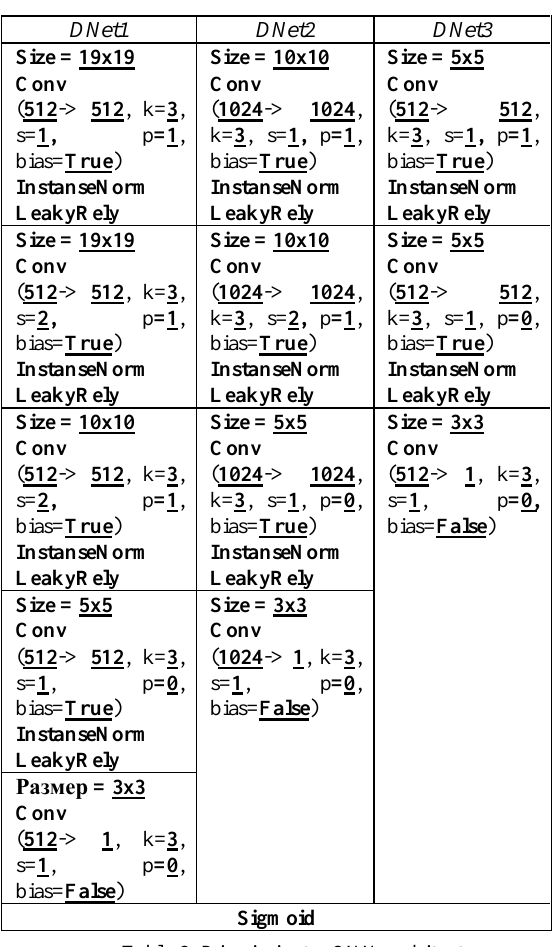
Table 2. Discriminator CNN architecture.